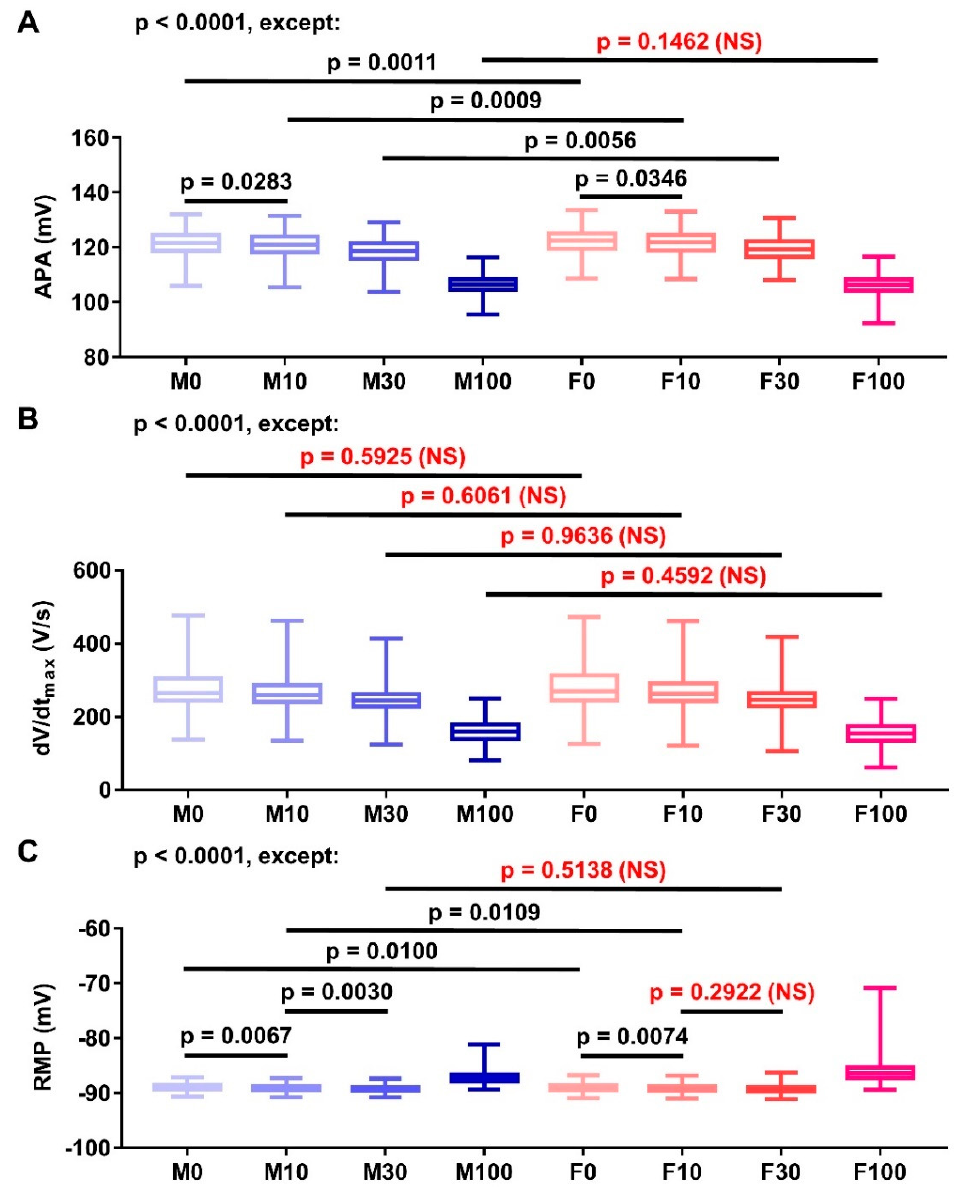
Figure 6. The comparison of other action potential properties (i.e., APA ( A ), dV/dt max ( B ) and RMP ( C )) in various concentrations of naringenin. The data were extracted from the population of models consisting 1000 model variations shown in Figure 4. Statistical analyses were performed using one- way analysis of variance (ANOVA) with Tukey’s multiple comparison test between concentrations in males and females, and in the same concentrations across sex (i.e., M0 vs. M10, M0 vs. M30, M0 vs. M100, M10 vs. M30, M10 vs. M100, M30 vs. M100, F0 vs. F10, F0 vs. F30, F0 vs. F100, F10 vs. F30, F10 vs. F100, F30 vs. F100, M0 vs. F0, M10 vs. F10, M30 vs. F30, and M100 vs. F100). Statistical significance is reached if p < 0.05. (APA = action potential amplitude; NS = not significant; RMP = resting membrane potential).